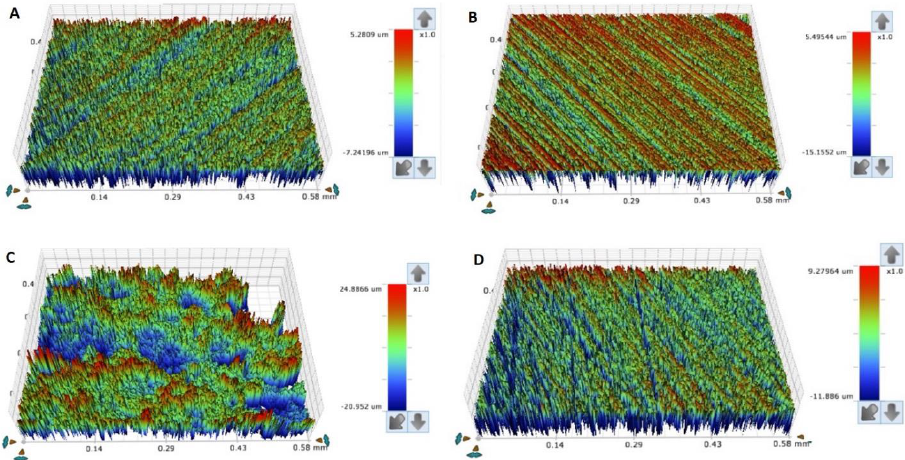
Figure 3. ( A – D ) Representative surface roughness images of scanned areas of HP and ASIGA groups at 120 min. ( A ) HP, ( B ) 0-degree, ( C ) 45-degree, ( D ) 90-degree.